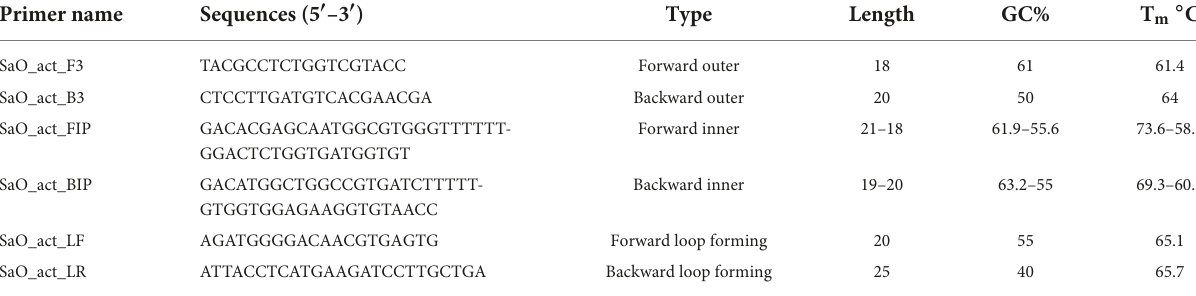
TABLE 2 Primer sequences designed for the validation of LAMP